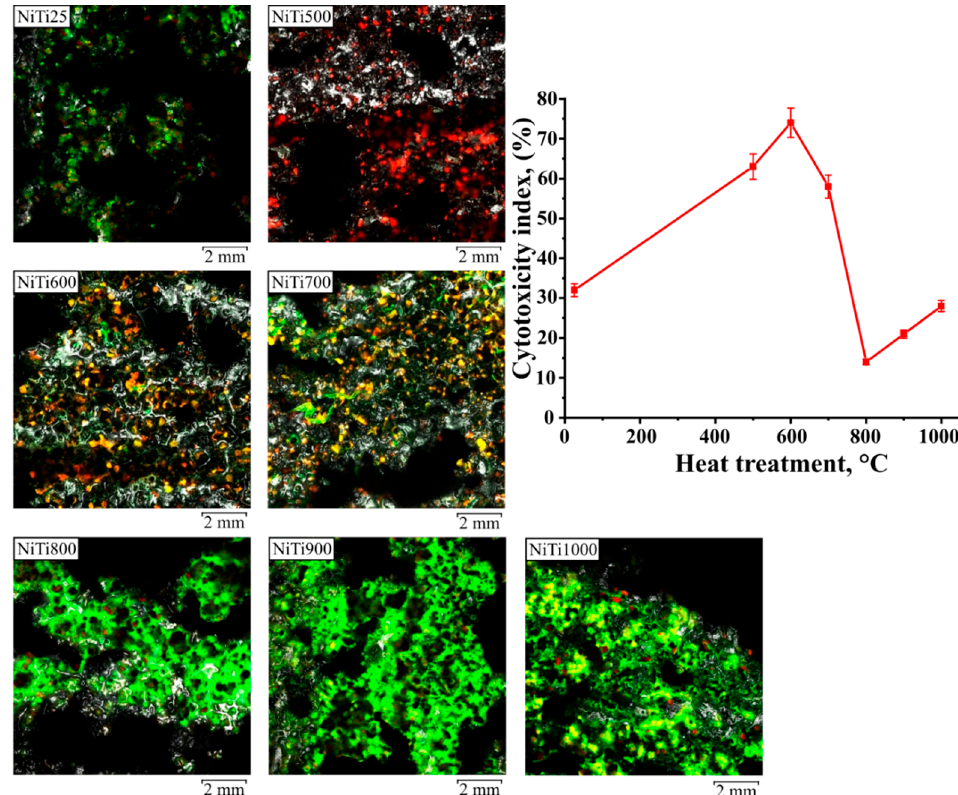
Figure 7. CLSM images of various samples of NiTi after cell growth MCF-7 for 3 days, green color used for visualization of viable MCF-7 cells; cytotoxicity level of the modified porous NiTi-based alloy samples with MCF-7 cells after 24 h of incubation, measured by the MTT test (red line).